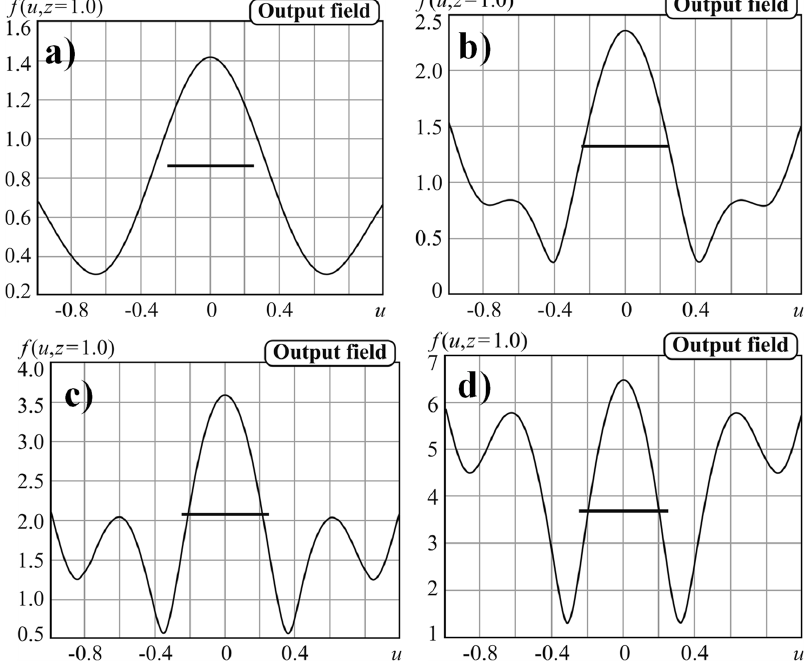
Figure 7. Amplitude of the field of Equation (6) at a distance z = λ for N = 20 and T = 5 λ at different values of the coefficient: ( a ) a = 1.5, ( b ) a = 5, ( c ) a = 10, ( d ) a = 20.